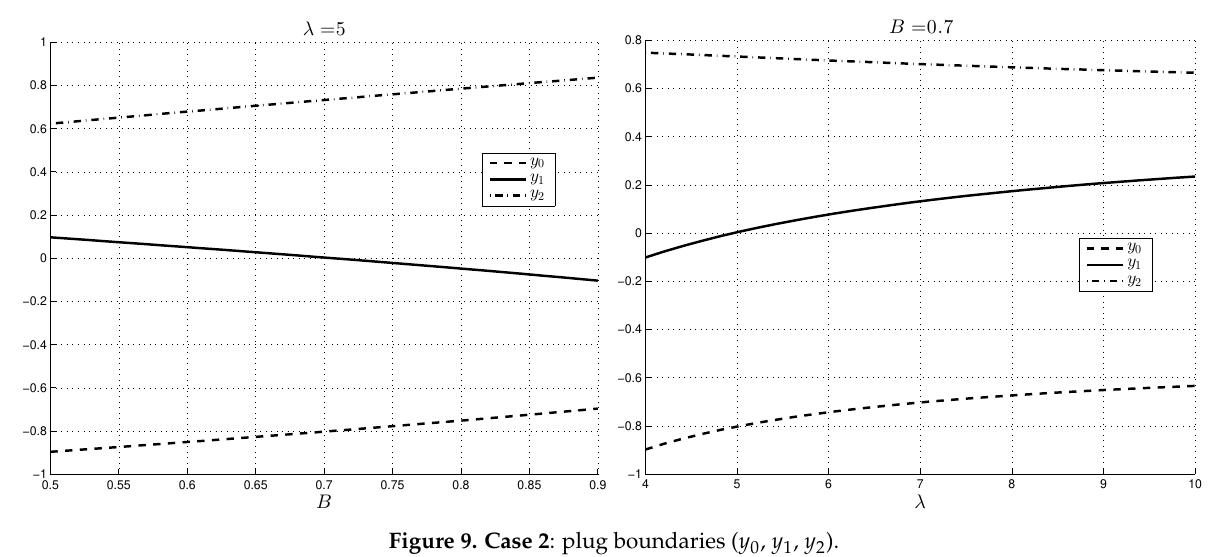
Figure 9. Case 2 : plug boundaries ( y 0 , y 1 , y 2 ).